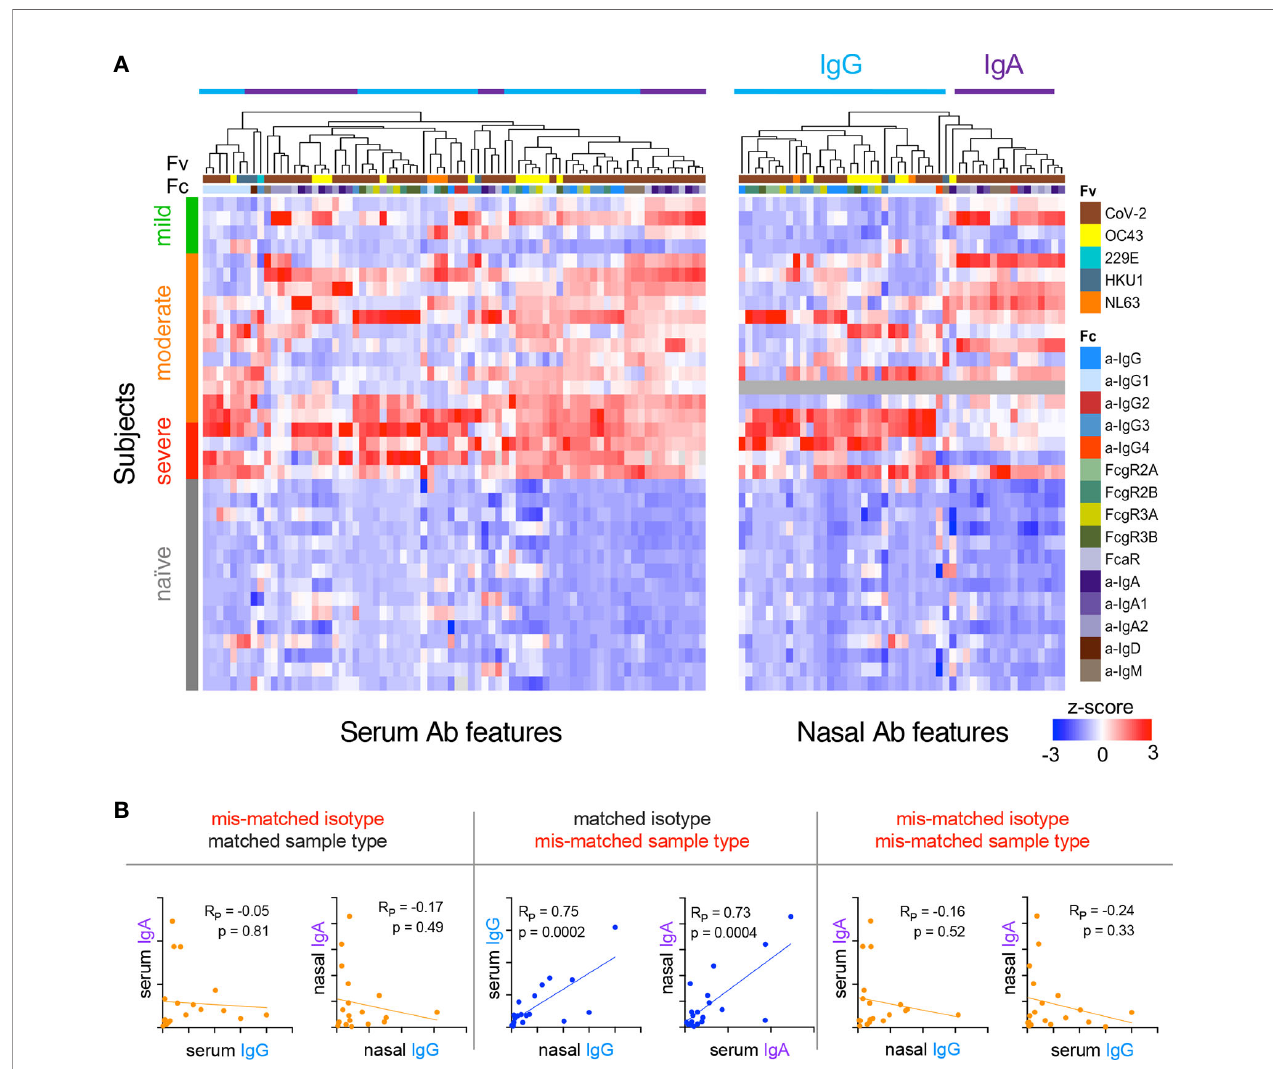
FIGURE 4 | Relationships among subjects and Ab features in serum and nasal wash. (A) Heatmap of fi ltered and hierarchically-clustered Fc array features in serum (left) and nasal wash (right) across subjects with varying infection or disease status. Each row represents an individual donor. Disease severity is shown on the left annotation bar. Each column represents an Fc Array measurement, with antigen speci fi city (Fv) and Fc characteristics (Fc) are indicated in top color bars. Responses are centered and scaled per feature and the scale range truncated at +/-3 SD. Relatively high responses are indicated in red, and low responses in blue. Color bars at bottom indicate the divergent clusters of IgG-related (blue) and IgA-related (purple) responses observed in nasal wash samples. (B) Representative scatter plots of the correlative relationships between IgA and IgG anti-S1 responses in nasal and serum samples. Pearson correlation coef fi cients (R P ) and p values of unpaired two- tailed t-tests with Welch ’ s correction are